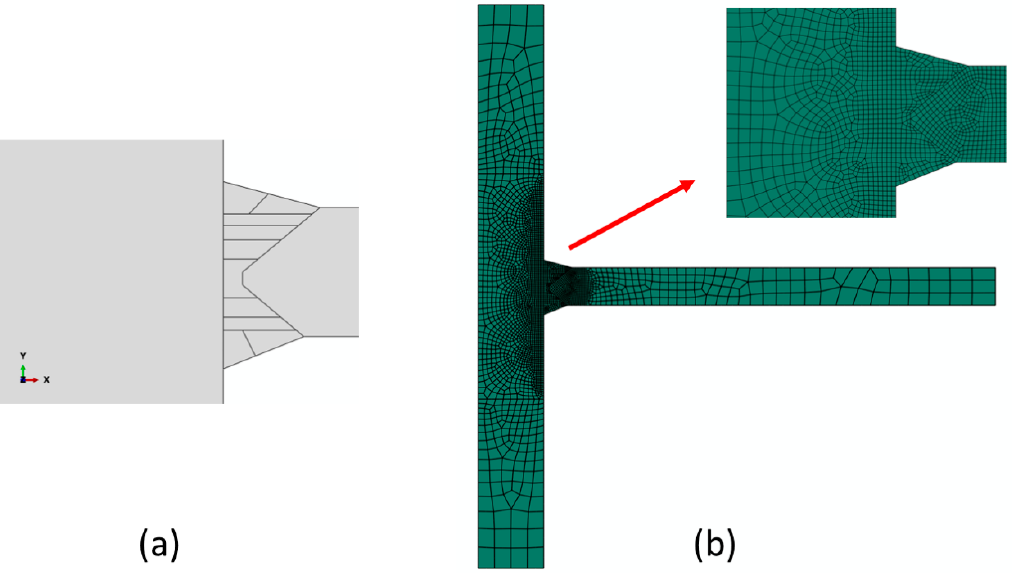
Figure 3. Illustration of T-joint model, showing: ( a ) weld beads details in FE model; ( b ) FE mesh. Table 4. Start and finish temperatures of the phase transformations. Start Temperature Finish Temperature Phase ◦ C ◦ C Ferrite 800 600 Bainite 600 450 Martensite 400 200 Austenite 730 840 Table 5. Time constants used in the phase transformation. Phase Transformation Start τ ij Finish τ ij From To (Sec) ( i ) ( j )